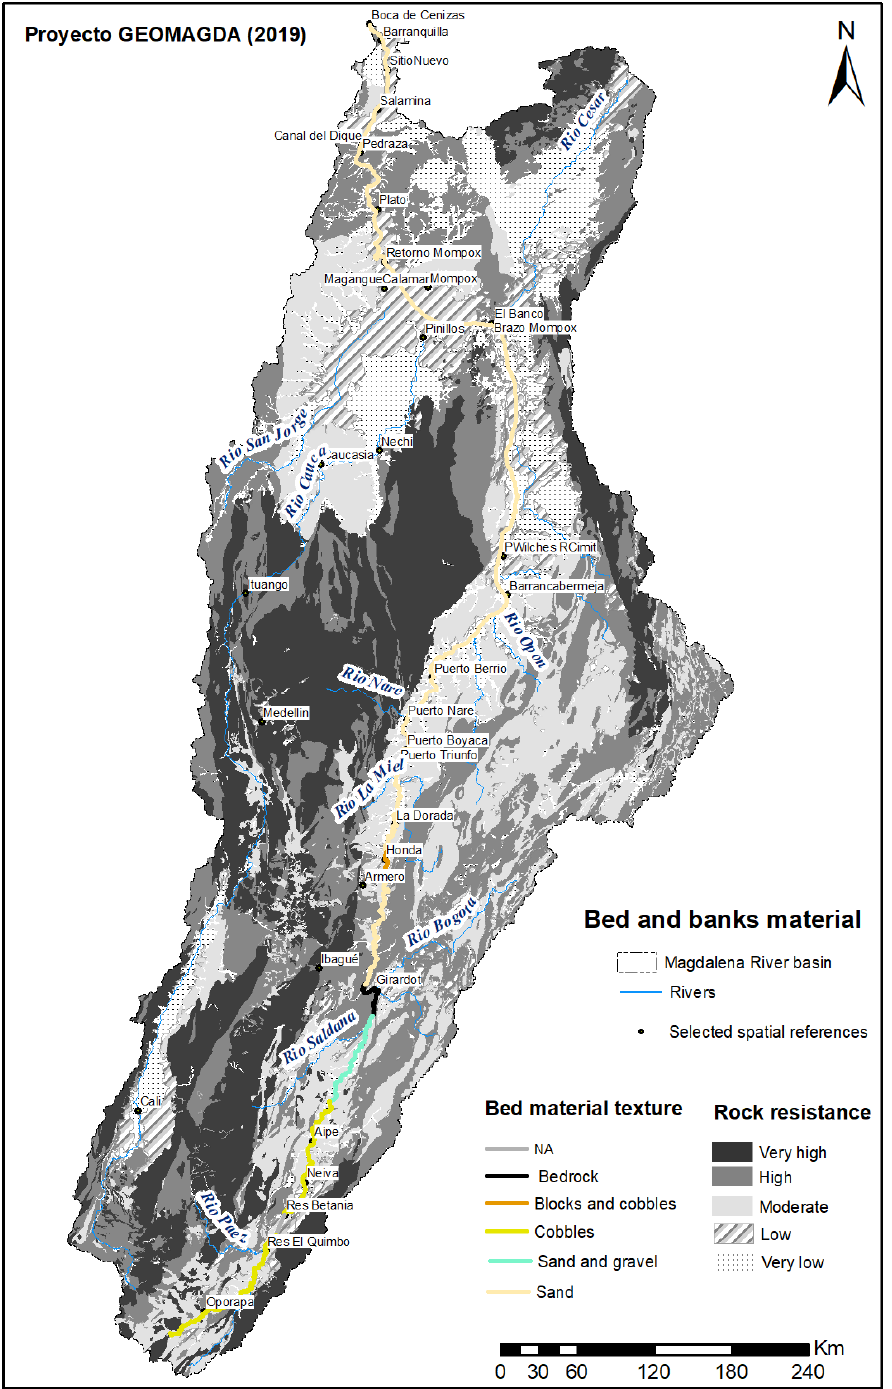
Figure 7. Sediments (actually material of bars and islands) and banks material at macro scale, Magdalena basin.